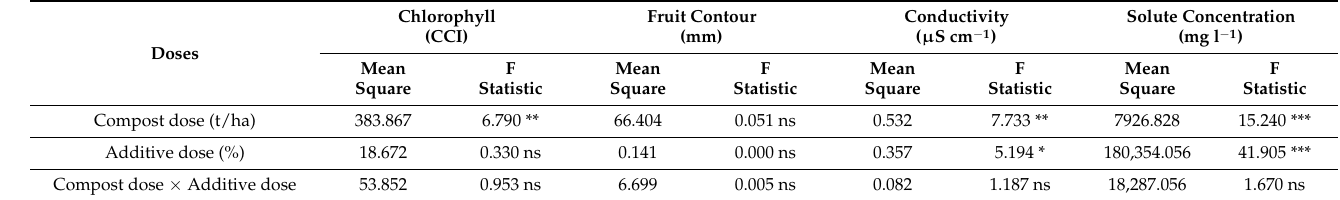
Figure 4. Responses of other variables to the treatments applied in the field trial for the pepper crop. The chlorophyll ( A ), the fruit contour ( B ), the conductivity ( C ), the solute concentration ( D ).The values are expressed as relative values in percentage, using, as a reference (100%), control 80. Comparison against control 80 was performed with the Dunnett test (* means significant difference at p ≤ 0.05 with the control 80, ns means not significant difference at p ≤ 0.05 with the control 80). Table 5. ANOVA for chlorophyll content and several fruit parameters, in the pepper crop. The location, the year and the plot were considered random factors, whilst the compost dose and the additive (PGPR + biochar) were fixed factors (significance levels: *** p ≤ 0.001; ** 0.001 < p ≤ 0.01; * 0.01 < p ≤ 0.05; ns, not